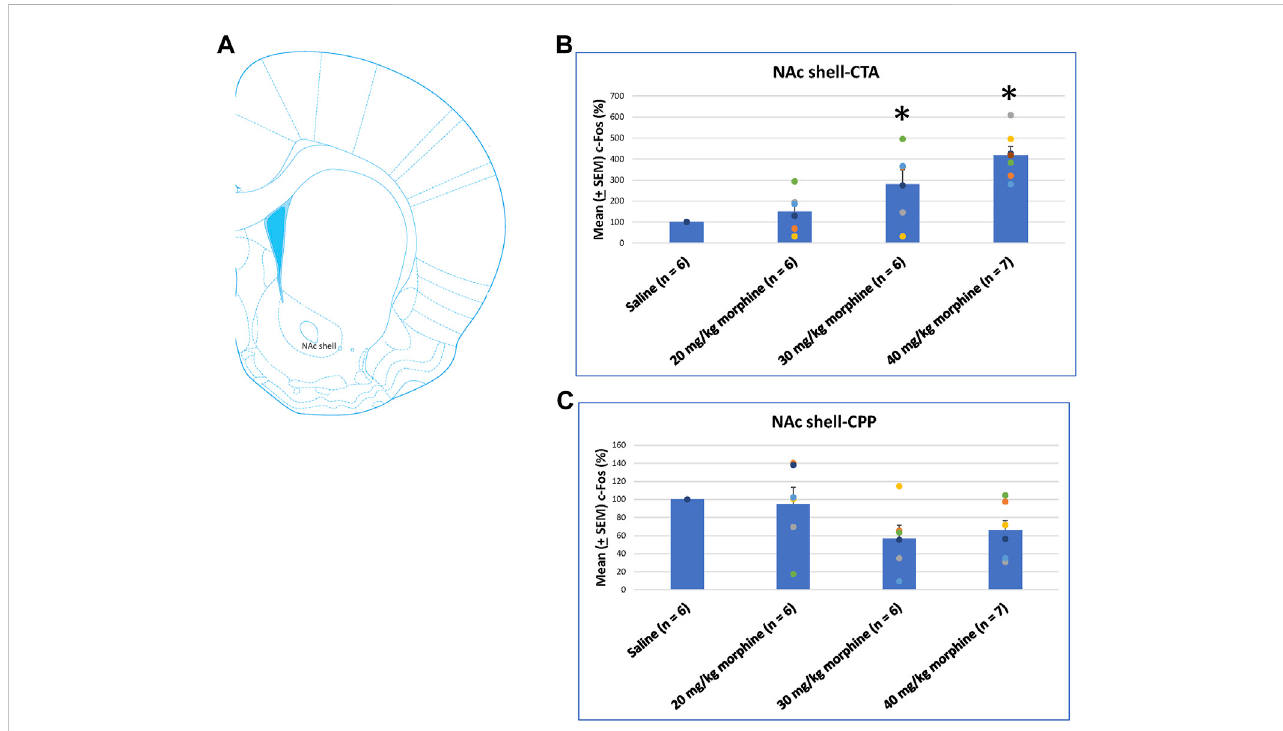
FIGURE 10 (A) Representativeimageofc-Fosimmunoreactivityinthenucleusaccumbensshell(NAcshell).Mean(±SEM)c-Fos(%)intheNAcshellfollowing (B) CTA and (C) CPP tests. * p < 0.05 when comparing the saline for CTA and CPP (both, n = 6) or with morphine in doses of 20 mg/kg for CTA and CPP (both, n = 6), 30 mg/kg for CTA and CPP (both, n = 6), and 40 mg/kg for CTA ( n = 6) and CPP ( n =